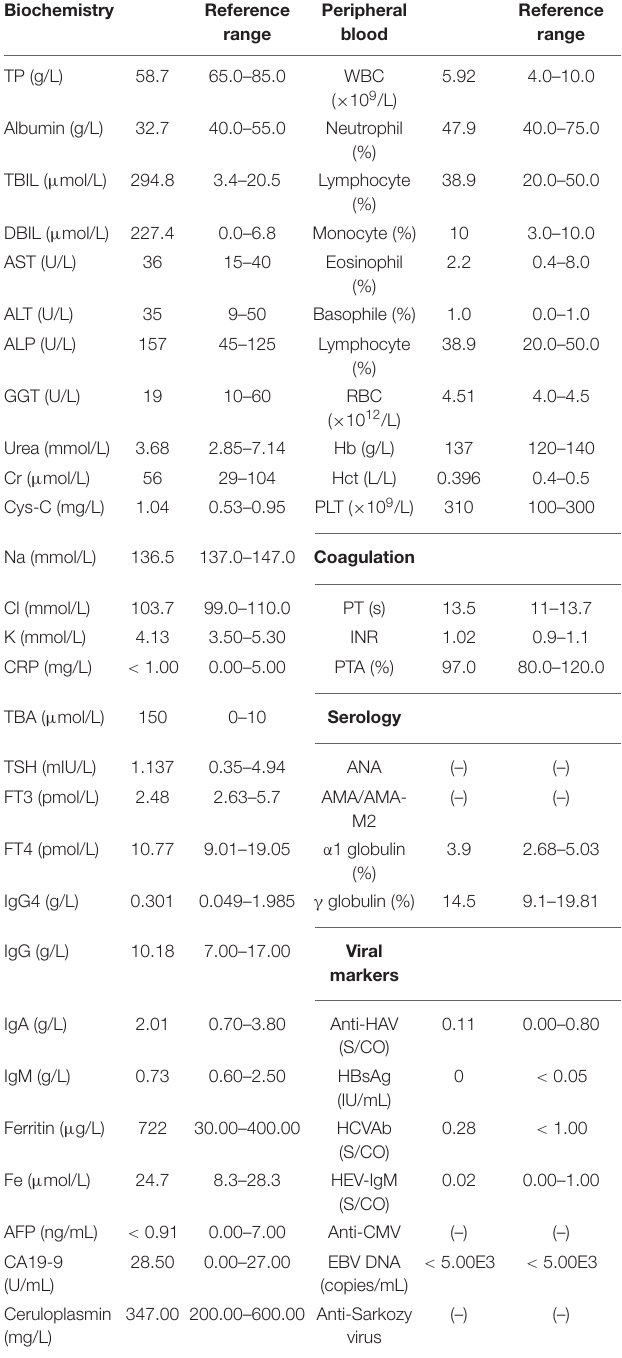
TABLE 1 | Laboratory data on admission at previous